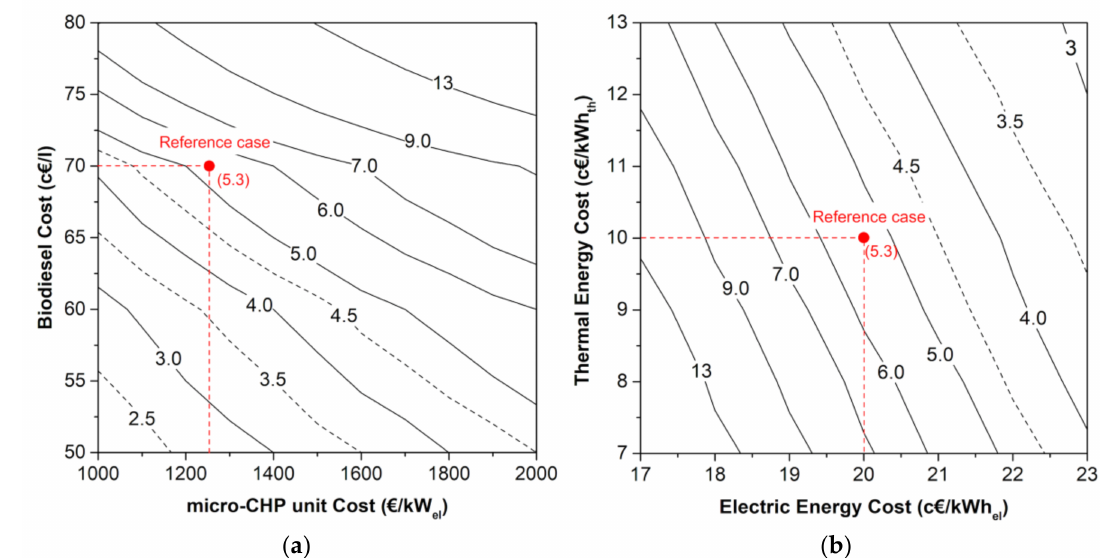
Figure 16. Payback period maps: ( a ) influence of the specific cost of CHP and biodiesel; ( b ) effect of the cost of electric and thermal